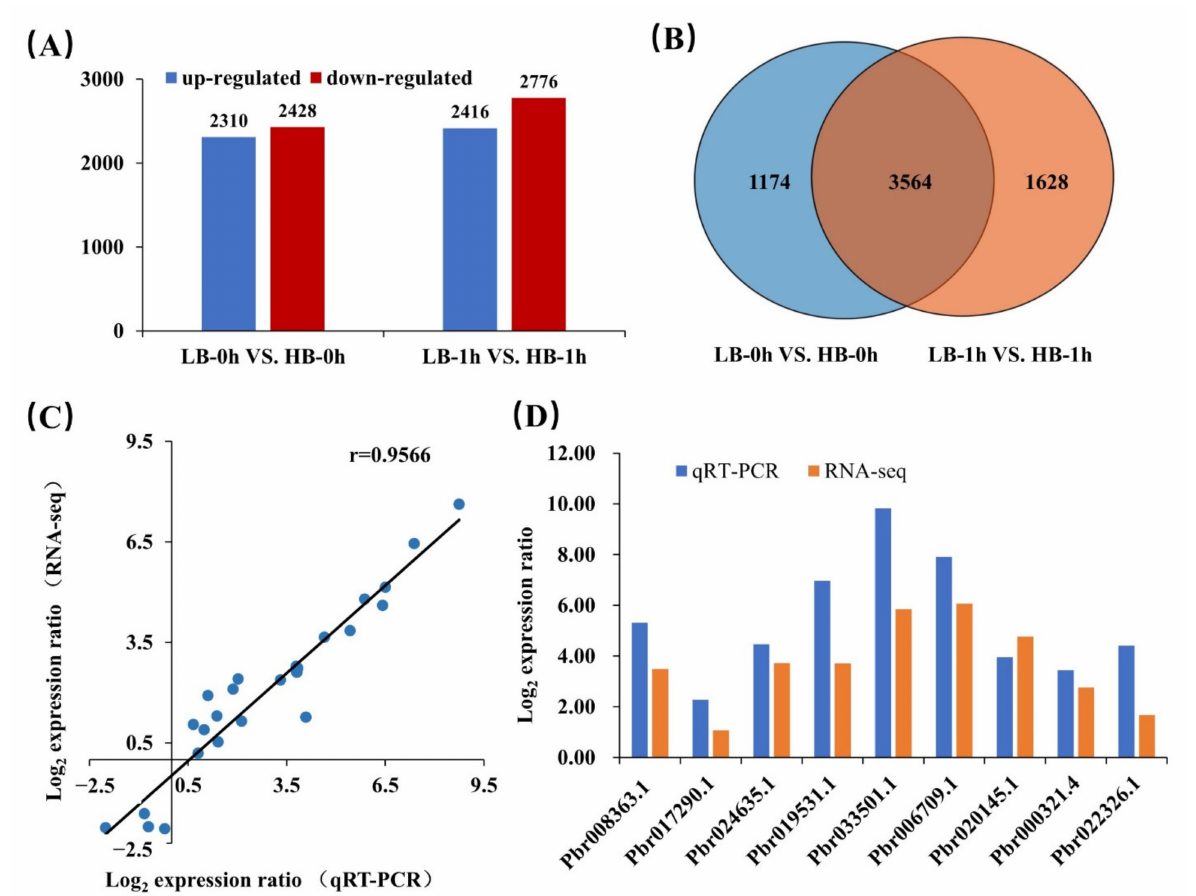
Figure 3. Characteristics and qRT-PCR validation of the differentially expressed genes (DEGs). ( A ) Numbers of DEGs in pairwise comparisons in two sand pear cultivars at 0 h and 1 h. ( B ) Venn diagram showing the number of DEGs in two sand pear cultivars at 0 h and 1 h. ( C ) Correlation analysis of the DEGs expression ratios obtained from the qRT-PCR and RNA-seq data of 26 DEGs ( p < 0.05). ( D ) Expression ratios of nine phenylpropanoid and flavonoid biosynthesis-related genes quantified by qRT-PCR and